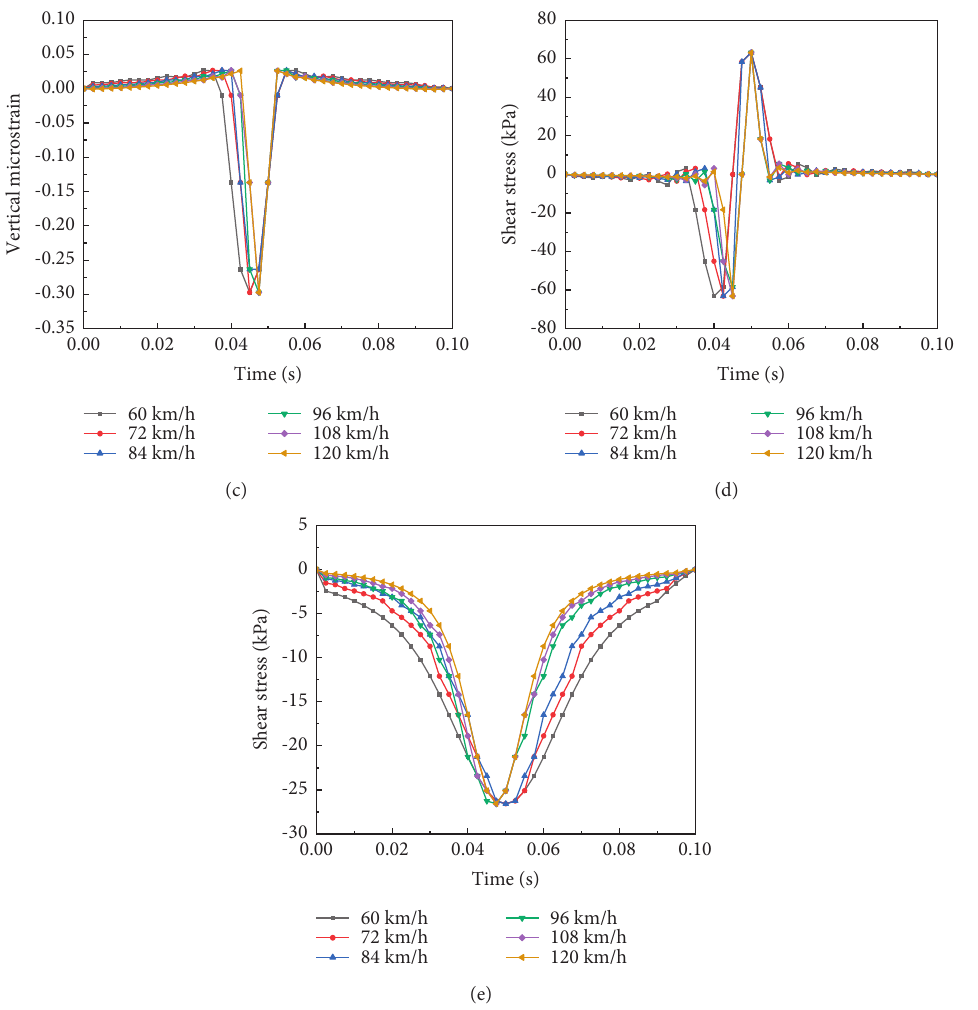
Figure 11: Time history curve of each index of structure I. (a) Time history curve of vertical displacement of road meter at different speeds. (b) Time history curve of vertical stress of road surface at different speeds. (c) Vertical micro strain time history curves of road meters at different speeds. (d) Time history curve of longitudinal shear stress of road surface at different speeds. (e) Time history curve of transverse shear stress at layer under different